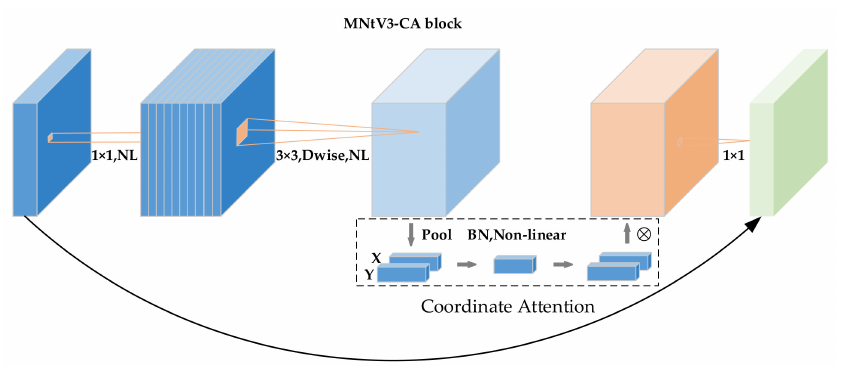
Figure 6. The structure of MNtV3-CA